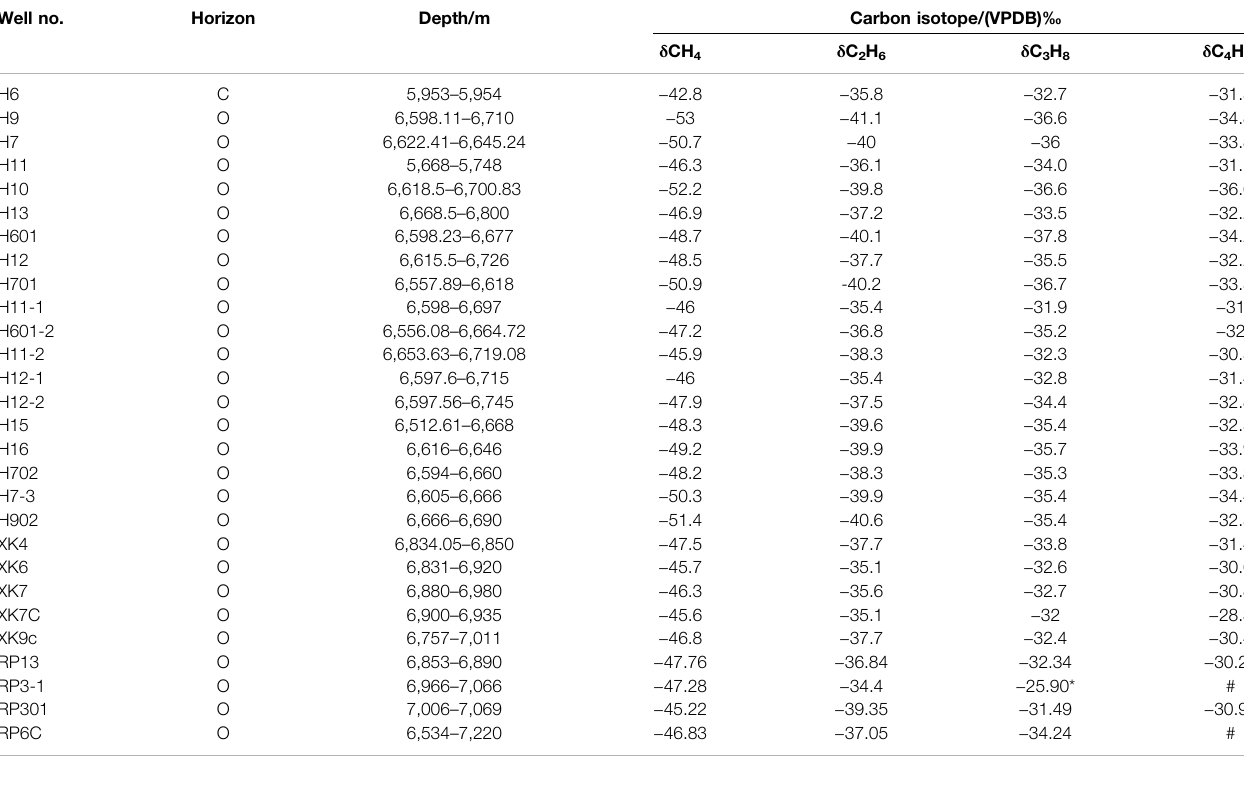
TABLE 3 | Carbon isotope analysis data of Ordovician natural gas in the Halahatang Area. Well no.